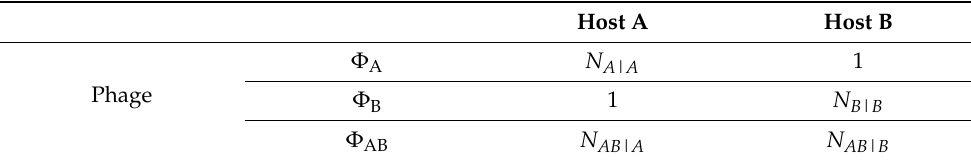
Table 2. Host-specific growth of different phages per